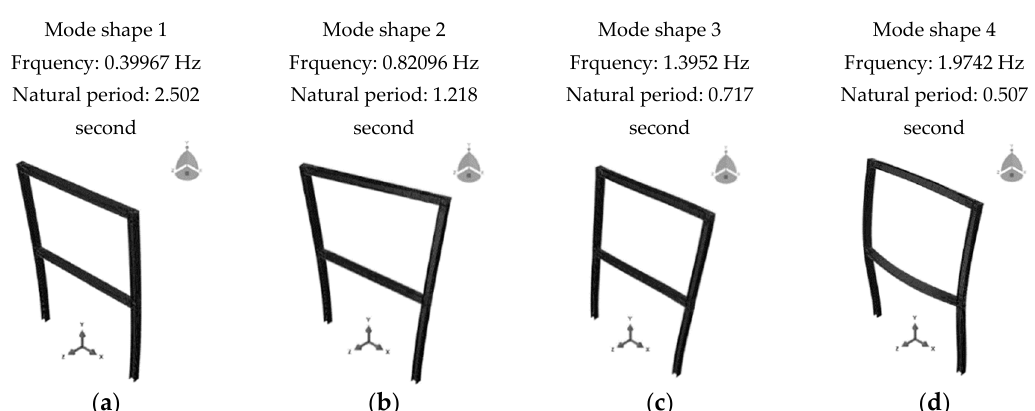
Figure 19. Structural eigen modes and eigen periods. ( a ) Mode shape 1; ( b ) Mode shape 2; ( c ) Mode shape 3; and ( d ) Mode shape 4.